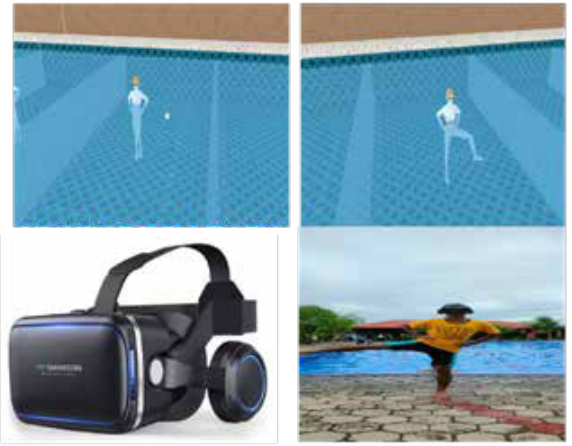
Figure 1. Virtual Reality-Based Tabata